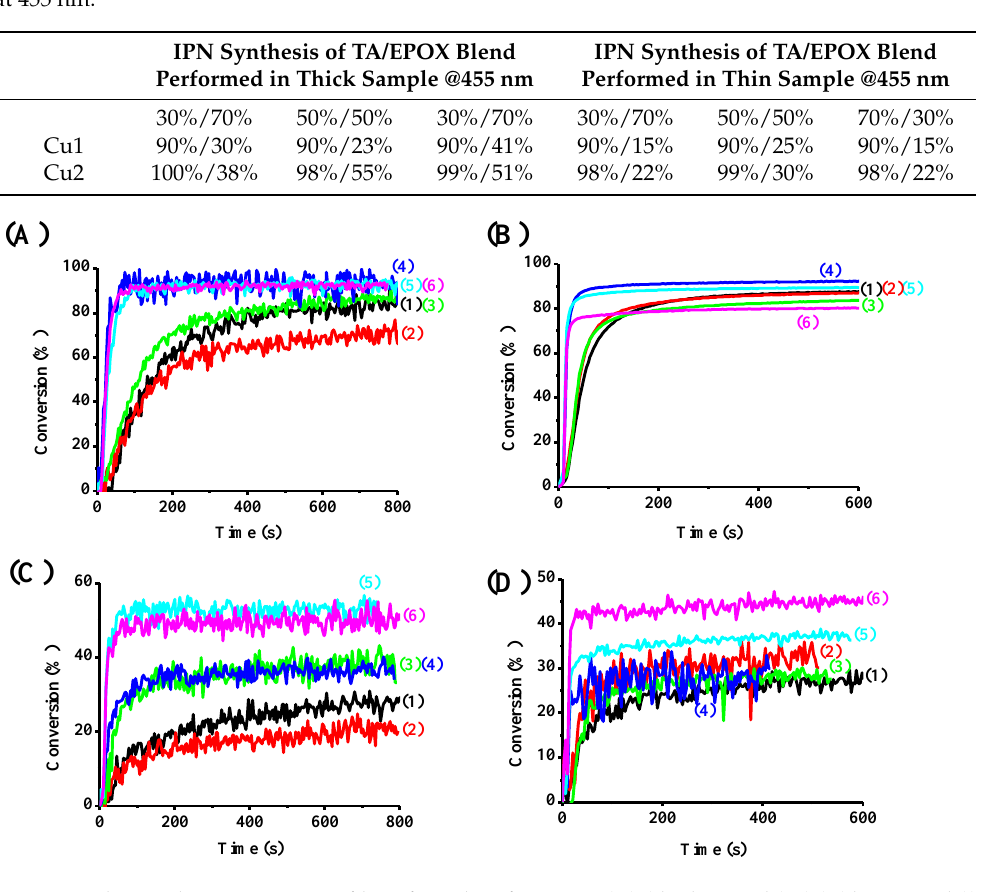
Table 5. Final conversions of acrylate and epoxides functions for the IPN synthesis of TA/EPOX blend using Cu1 (or Cu2)/Iod/NPG (0.1%/1%/1%/ w / w / w ) as PIS upon exposure to visible light at 455 nm. IPN Synthesis of TA/EPOX Blend Per- formed in Thick Sample @455 nm